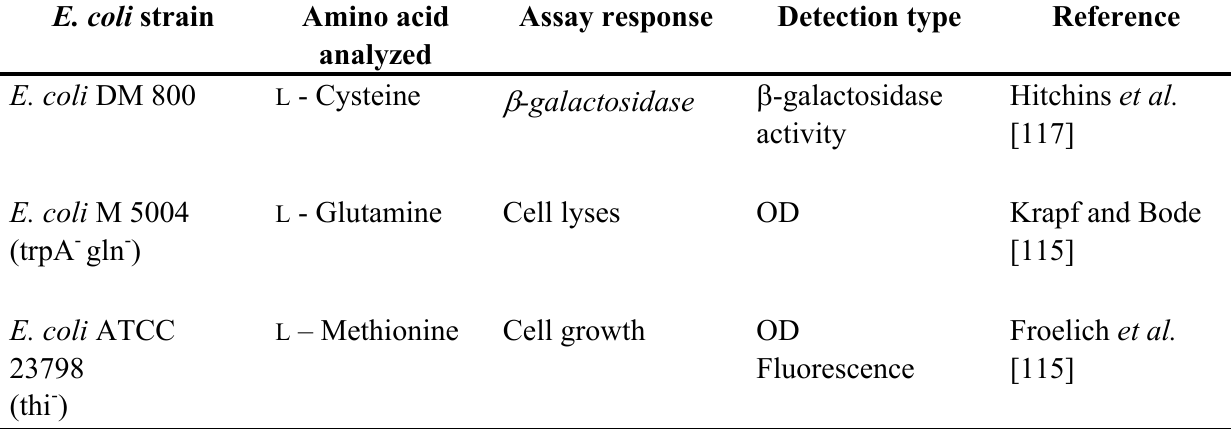
Table 2 . E. coli strains for bioavailable amino acid quantification. OD refers optical density, GFP denotes green fluorescent